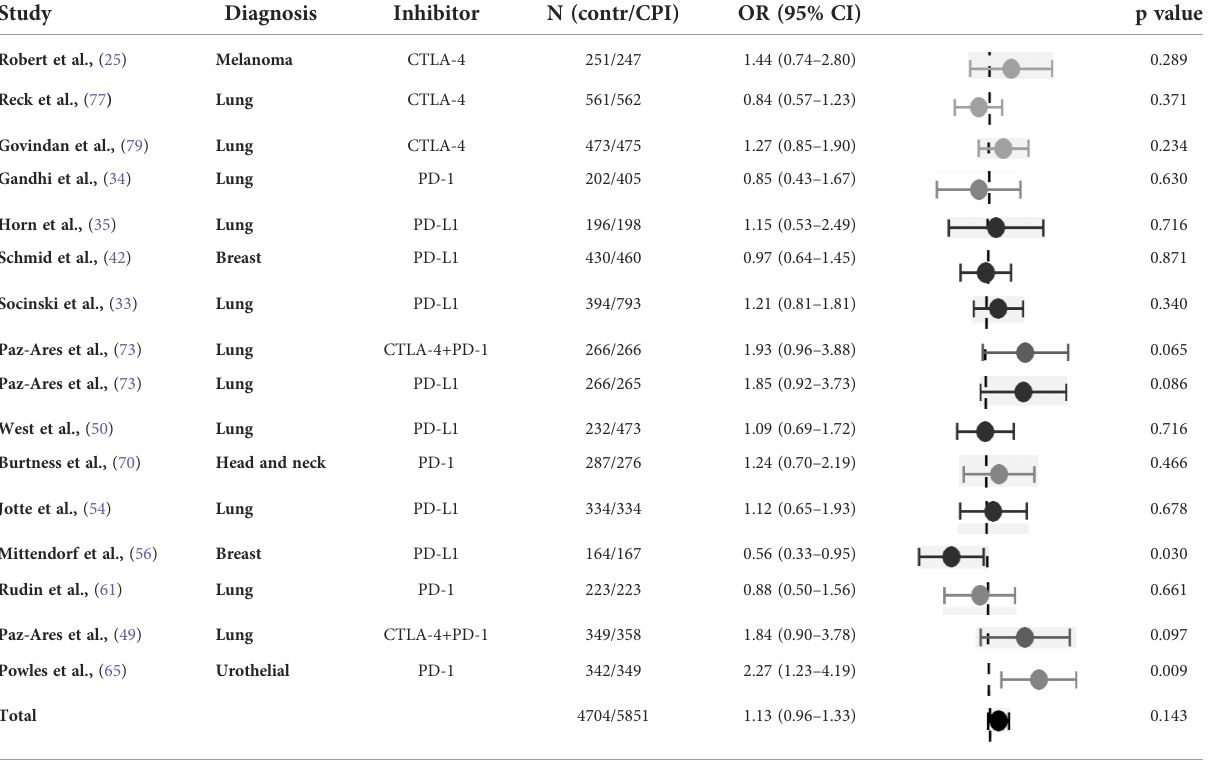
TABLE 8 Odds ratio of insomnia in randomised studies of checkpoint inhibitors combined with chemotherapy versus chemotherapy (control arm as reference).